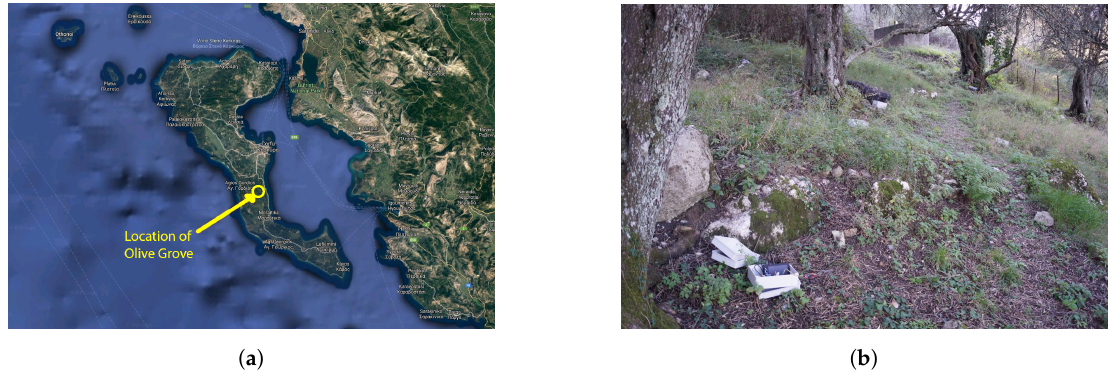
Figure 3. Deployment site for the experiment: ( a ) satellite view of the olive grove; and ( b ) installation sites on the olive